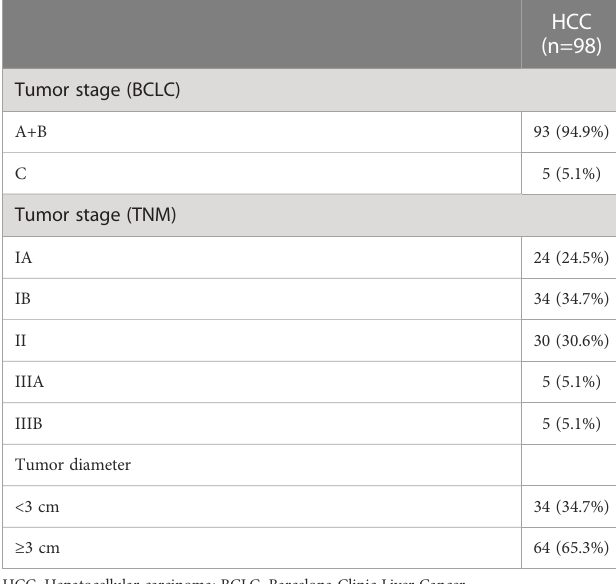
statistically signi fi cant difference between HCC patients, LC patients, and healthy subjects with regard to the mean values ± SD of platelet (PLT) count, hemoglobin (HGB), PLT, international normalized ratio (INR), fi brinogen (FBG), alanine aminotransferase (ALT), alkaline TABLE 2 The clinicopathological parameters of HCC patients.